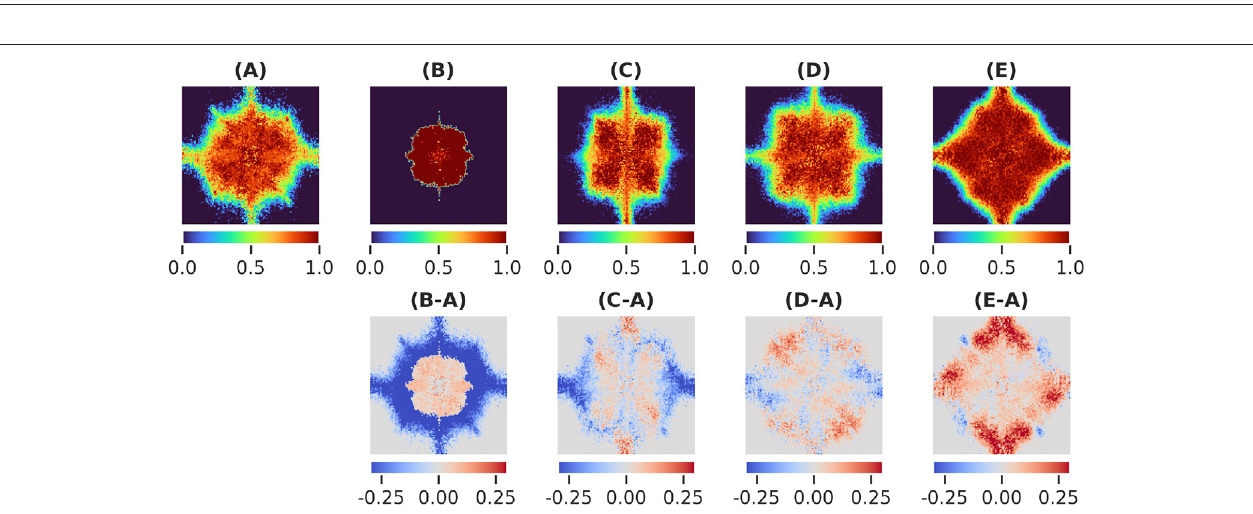
FIGURE 2 | A schematic of the preprocessing layer defined by the mask: the input x is transformed into the Fourier domain where it is filtered with a learnable mask M